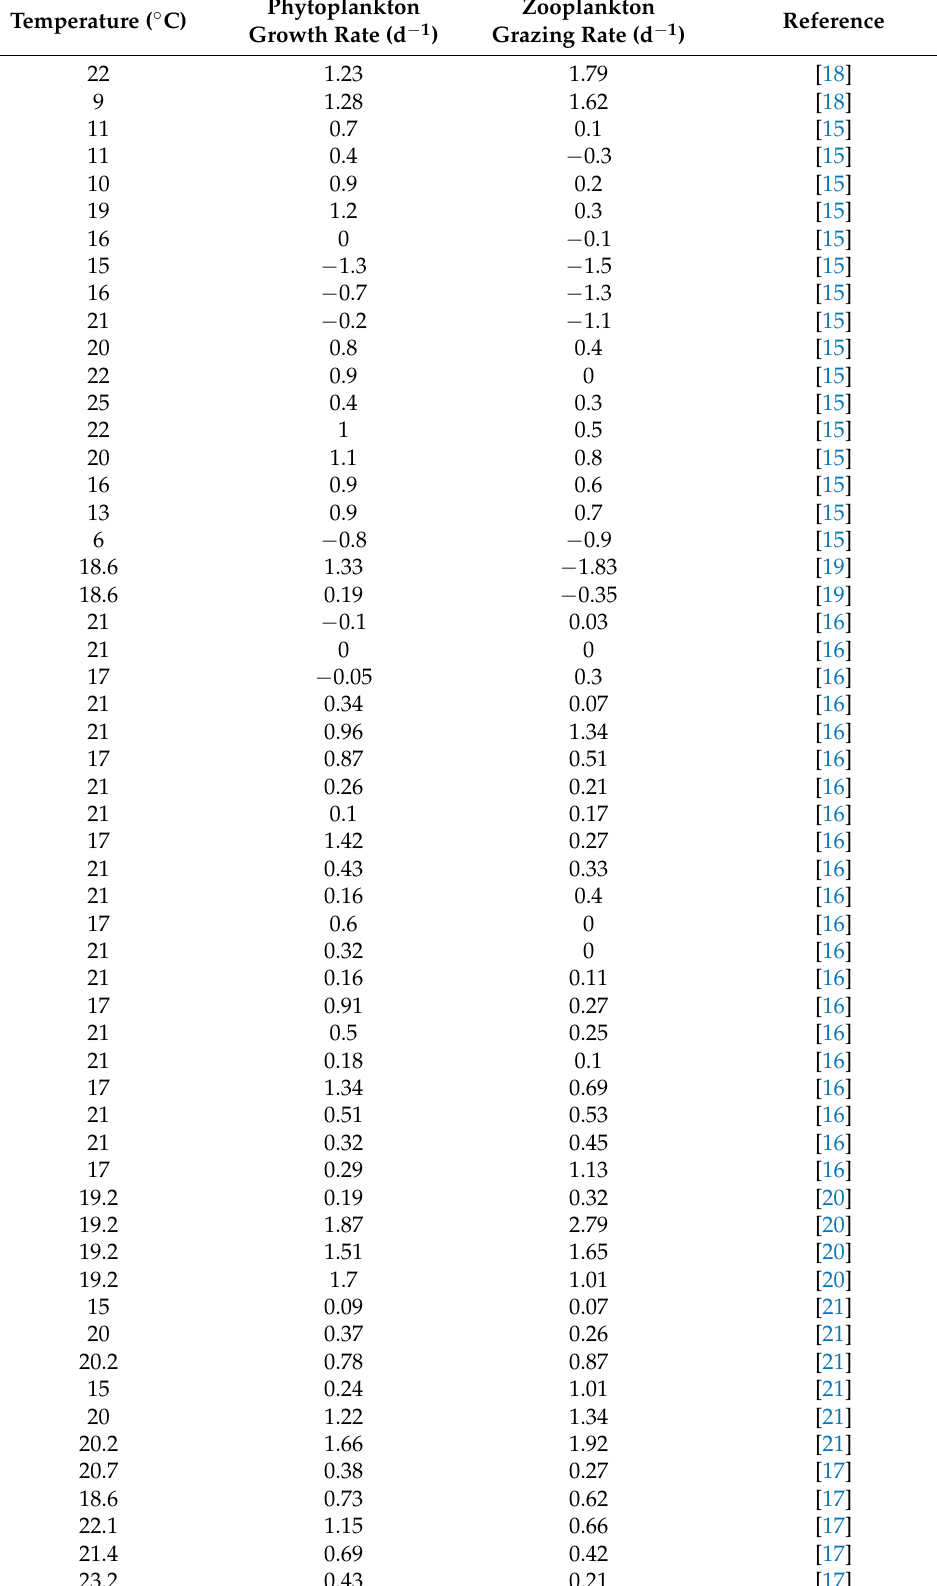
Table A2. Summary of 87 paired phytoplankton growth rates and zooplankton grazing rates that were combined with results of this study (Table A1) to produce Figure